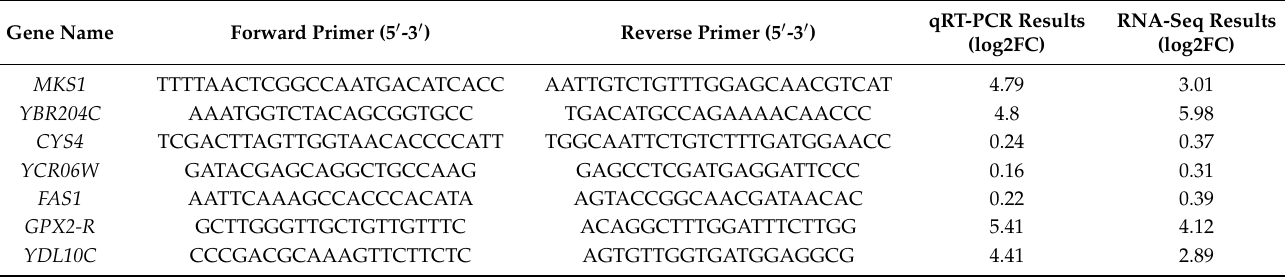
Table 1. Primers for qRT-PCR and verification of RNA-Seq